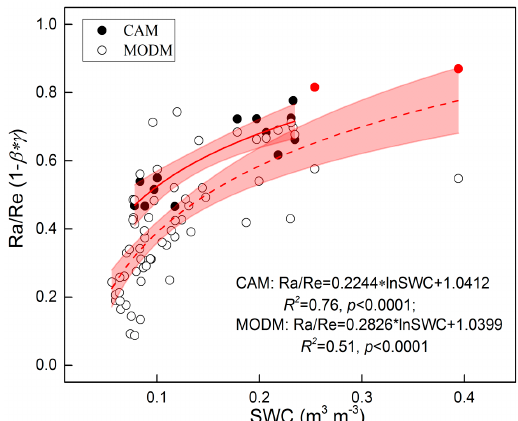
Figure 8. The effect of soil water content (SWC) on the ratio of autotrophic respiration (Ra) and ecosystem respiration (Re) (1 − β * γ ). CAM is derived from the camber-based Re components measurements. MODM is estimated from satellite-based Re partitions. The red dots are abnormal measurements due to the high moisture condition. The red solid and dashed curves are the best fitted lines for the relationship between camber-based and satellite-based 1 − β * γ and SWC, respectively. The shadows are the 95% confidence bands for corresponding fitting curves.